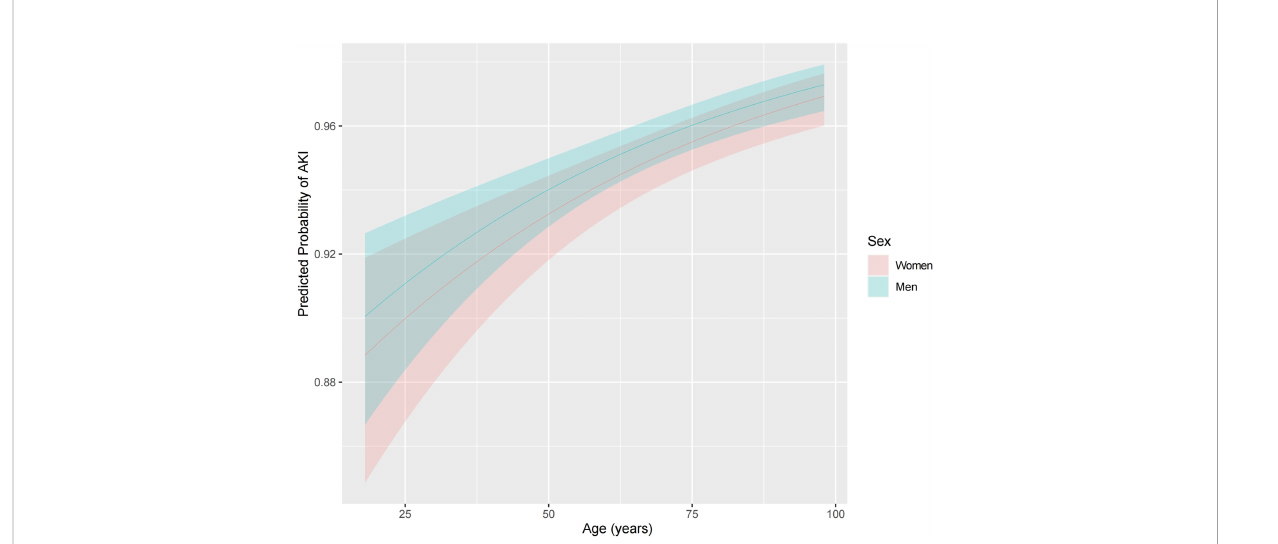
FIGURE 3 Effect of age on the adjusted incidence of acute kidney injury in men and women. Models were adjusted for all variables, including age, BMI, ethnicity, admission type, hypertension, coronary atherosclerosis, heart failure, diabetes mellitus, COPD, cerebral infarction, chronic liver disease, chronic kidney disease, tumor, APS III, OASIS, SOFA, heart rate, MAP, RR, temperature, SpO2, WBC, hemoglobin, platelet, PH, bicarbonate, BUN, creatinine, potassium, sodium, chloride, glucose, PT, APTT, lactate, vasopressor use, mechanical ventilation use, diuretic, aminoglycoside, statin, ACEI/ARBs. ACEI/ARBs, Angiotensin-converting enzyme inhibitors/angiotensin receptor blockers; AKI, Acute kidney injury; APS III, Acute Physiology Score III; APTT, Activated partial thromboplastin time; BMI, Body mass index; BUN, Blood urea nitrogen; COPD, Chronic obstructive pulmonary disease; OASIS, Oxford Acute Severity of Illness Score; PT, Prothrombin time; SA-AKI, Sepsis associated acute kidney injury; SOFA, Sequential Organ Failure Assessment; RR, Respiratory rate; WBC, White blood